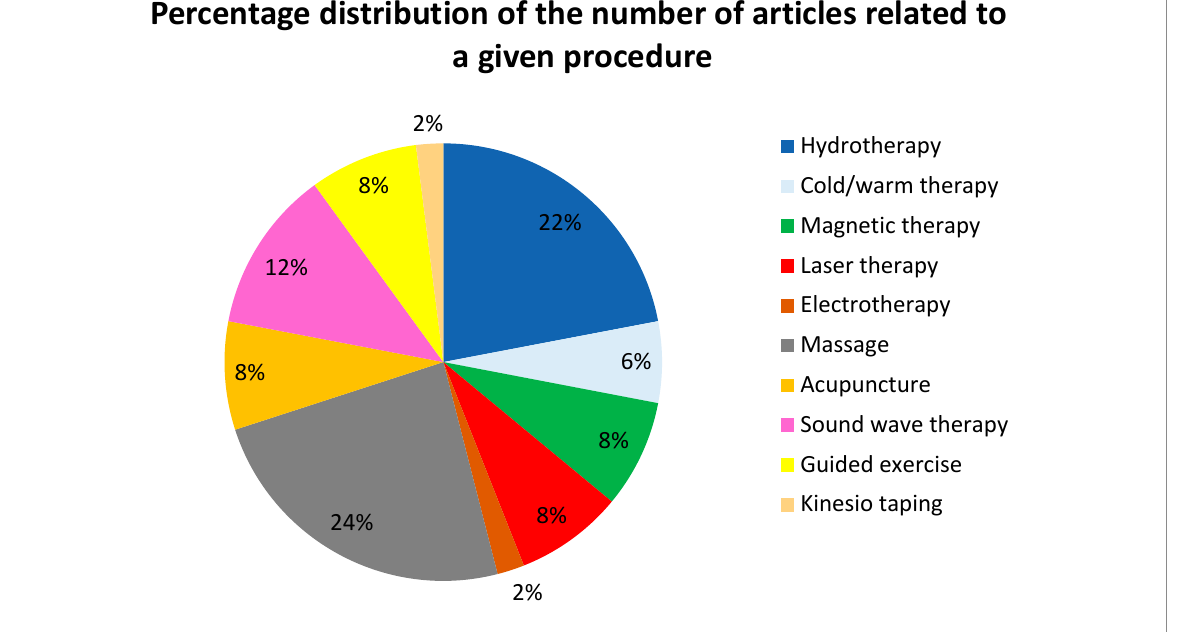
Figure 2. Percentage distribution of the number of articles related to a given procedure.